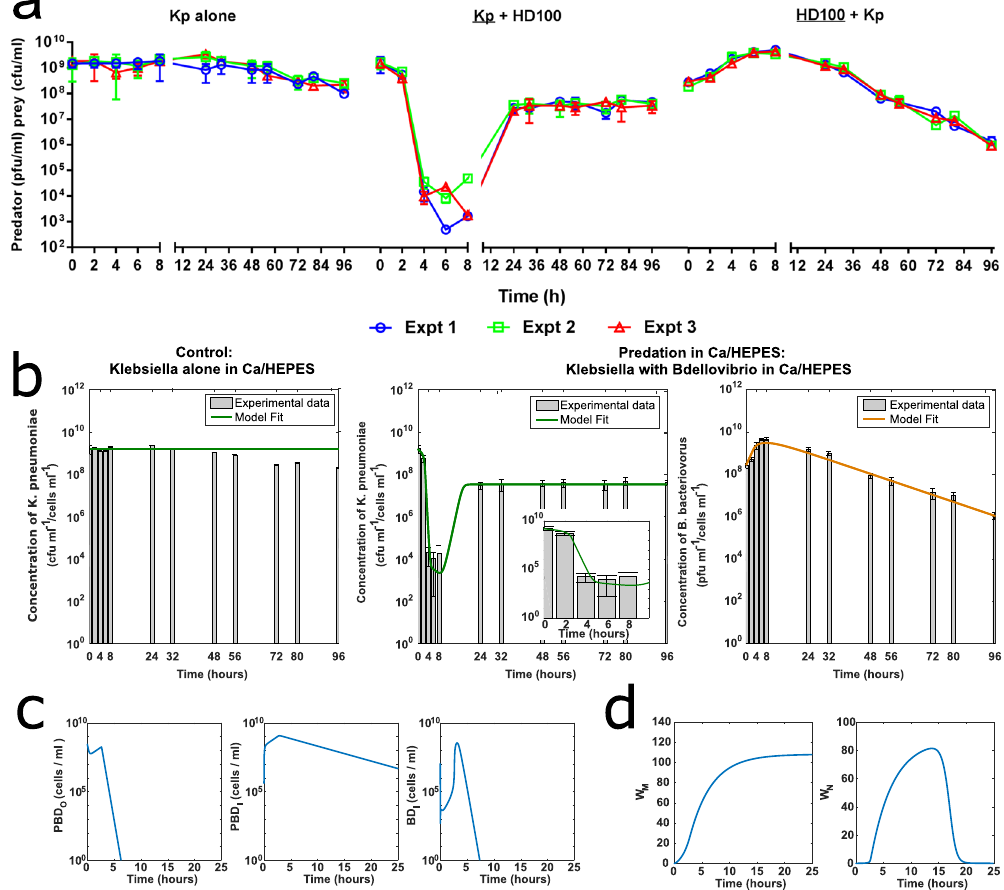
Figure 2. Predation Experimentally Measured and Modelled in Ca/HEPES buffer. ( a ) Graphs show individual biological repeats- separate experiments (Expt) of the live bacterial counts from predation in buffer experiments, results from each individual biological experiment are represented by the same colour line on each graph. Changes in the population of both K. pneumoniae prey (Kp + HD100) and B. bacteriovorus HD100 predator (HD100 + Kp) were enumerated periodically during the predation assay. As a control, prey suspended in Ca/HEPES was enumerated periodically in the absence of B. bacteriovorus HD100 predator (Kp alone). ( b ) Prey concentration (green line) initially shows a 6 log 10 reduction by 6 hours (see inset) before regrowth overtakes predation effects. Predator concentration (orange line) grows in line with the prey death for the first six hours then reduces, in line with experimental results. Experimental results reproduced from A shown as a bar plot, the model simulation lies within the error bars of the experimental results. ( c ) Model simulation results showing prey with a predator attached (PBD O ), prey with a predator inside (PBD I ) and inactivated predators (BD I ) over time. Attachment drops off after 5 hours due to prey becoming resistant.( d ) Model simulation of waste accumulation over time. Non-degradable waste increases monotonically leading to prey resistance whilst nutritious waste initially increases but is then depleted as it is used by the growing predominently resistant prey. Parameter values and further model validation are detailed in supplementary material. The model gives a good fit to the experimental